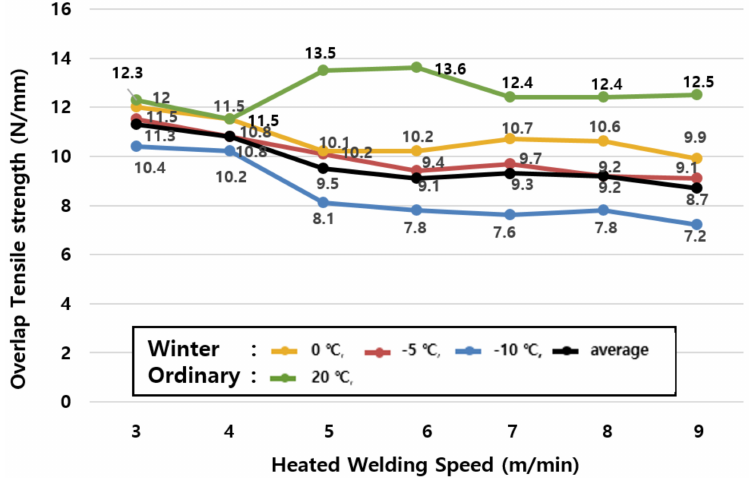
Figure 6. Tensile strength test results by joint construction temperature (winter